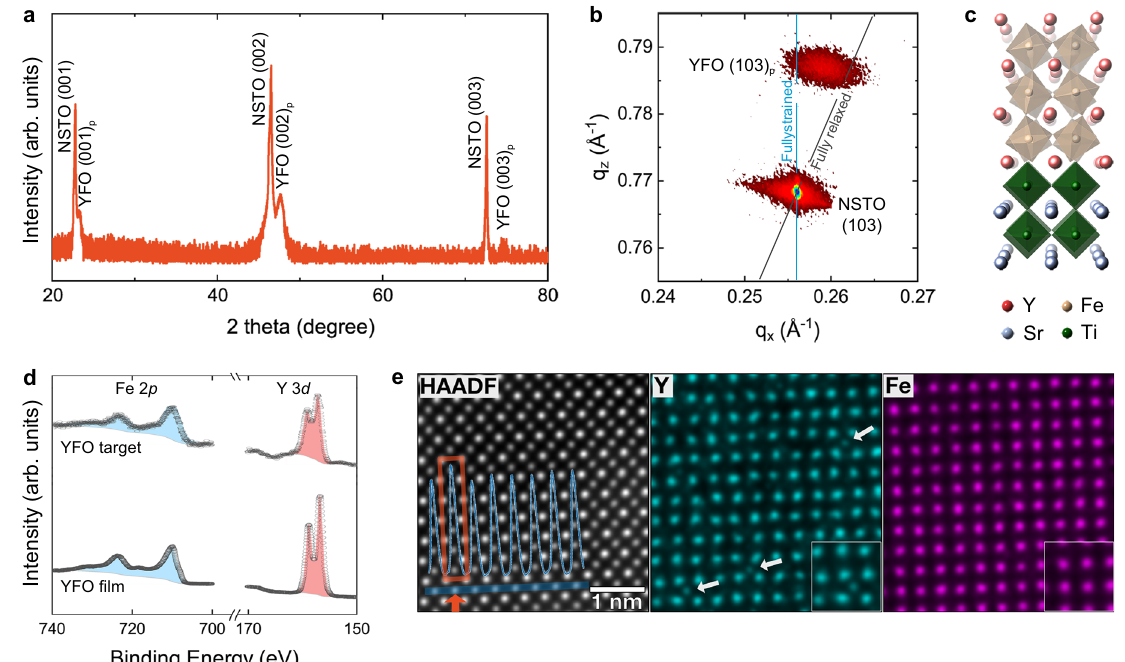
Fig. 1 Structure and defect analysis of YFO thin fi lms on NSTO substrate. a , b Structural characterization of the as-grown YFO/NSTO by high-resolution XRD ( a ) and asymmetric RSM ( b ). The subscript p denotes the pseudocubic unit cell. c Schematic of lattice structures of YFO and NSTO viewed along the orthorhombic [110] axis (pseudocubic [100] axis) of the YFeO 3 unit cell. d High-resolution Fe 2 p and Y 3 d core level spectra of the stoichiometric YFO target and the as-prepared YFO fi lm. e HAADF STEM image and denoised atomic resolution STEM EDS elemental mapping. The intensity pro fi le superposed in the HAADF STEM image is taken along the blue line. Fe – O atom columns rich in Y Fe defects show increased intensity in HAADF (red arrow) and a signal in the Y map (white